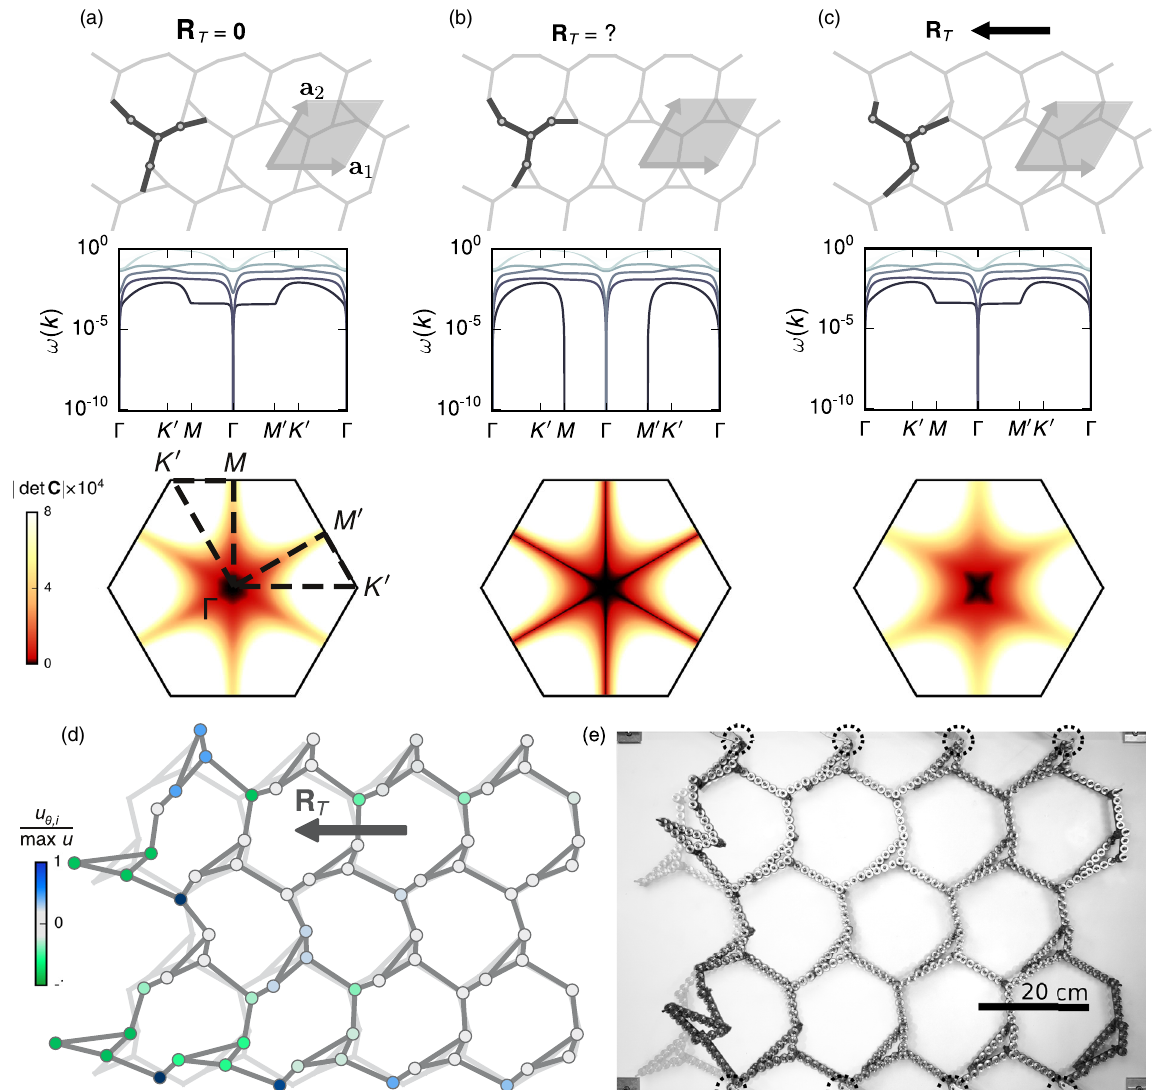
FIG. 2. Topologically polarized martini lattices. (a) – (c), Three members of a single-parameter family of martini lattices. The unit cell comprises four nodes (gray dots) and six unique links (thick black lines) and is repeated on a lattice built from primitive vectors f a 1 ; a 2 g . Below each lattice are shown the determinant of the Fourier-transformed tension-shear compatibility matrix in the Brillouin zone (intensity plot) and the lowest six eigenvalues along specific contours (line plots). The lattices (a) and (c) have a gapped spectrum everywhere except at the Γ point ( k ¼ 0 ). The topological polarization, calculated as described in the text, is 0 in (a) and − a 1 in (c). Lattice (b) has a gap closing along the line k x ¼ 0 , and the polarization is not well defined. (d) A strip of the polarized martini lattice with periodic boundary conditions along the y direction and free boundaries on the left and right. Only the left edge localizes zero modes, one of which is visualized by node colors and displacements. (e), A physical prototype of the framework in (a) made out of elements illustrated in Fig. 1. The nodes along the top and bottom edges (encircled) are pinned down but free to rotate. The left edge has been deformed relative to the unperturbed lattice (overlay); no such deformations are possible at the right edge or in the